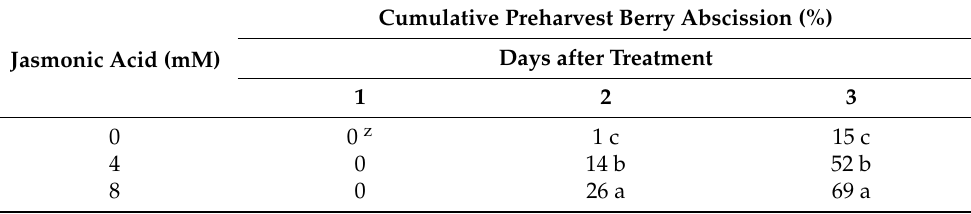
Table 2. The main effect of jasmonic acid on cumulative berry abscission through 3 DAT. Cumulative Preharvest Berry Abscission (%) Days after Treatment Jasmonic Acid (mM)